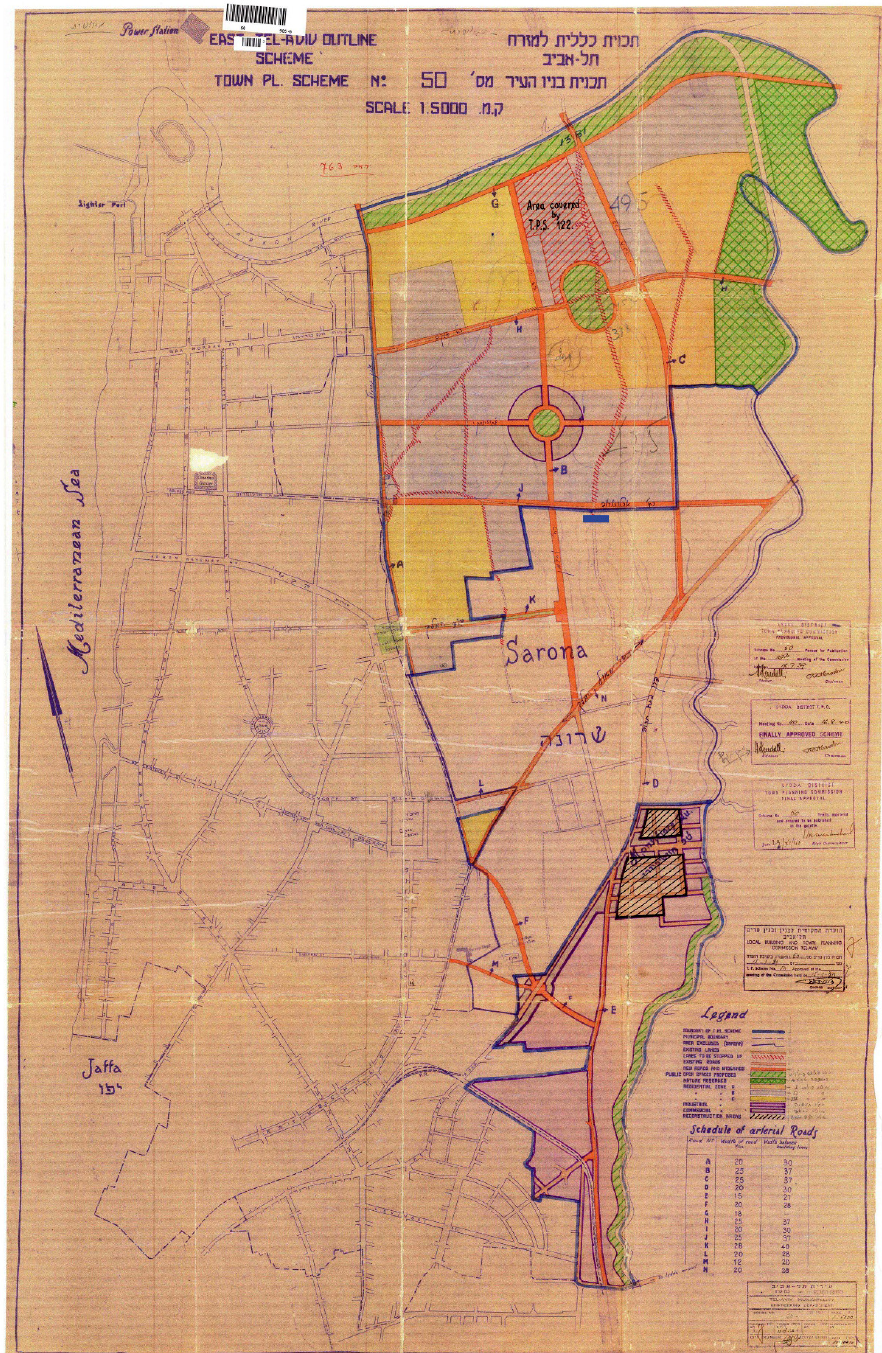
Figure 5. General plan for East Tel Aviv: Master Plan 50, 1940, with location of Be’eri estate in blue. The spots in yellow, orange, and oval define residential land use. Source: Taba Now